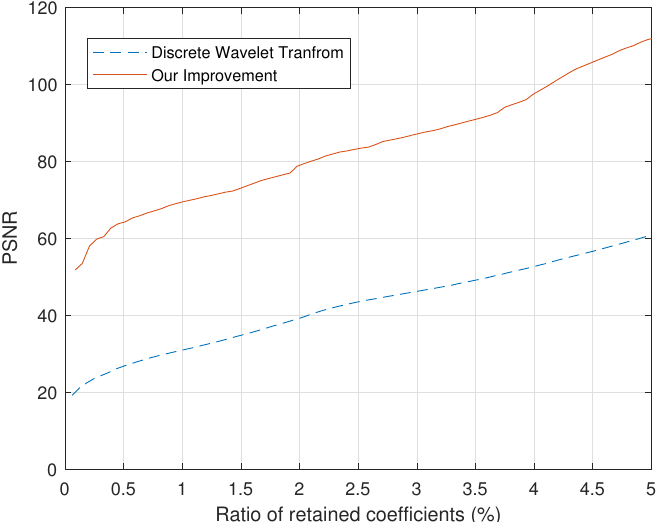
Figure 1. Approximation quality of the discrete wavelet transform and our improved